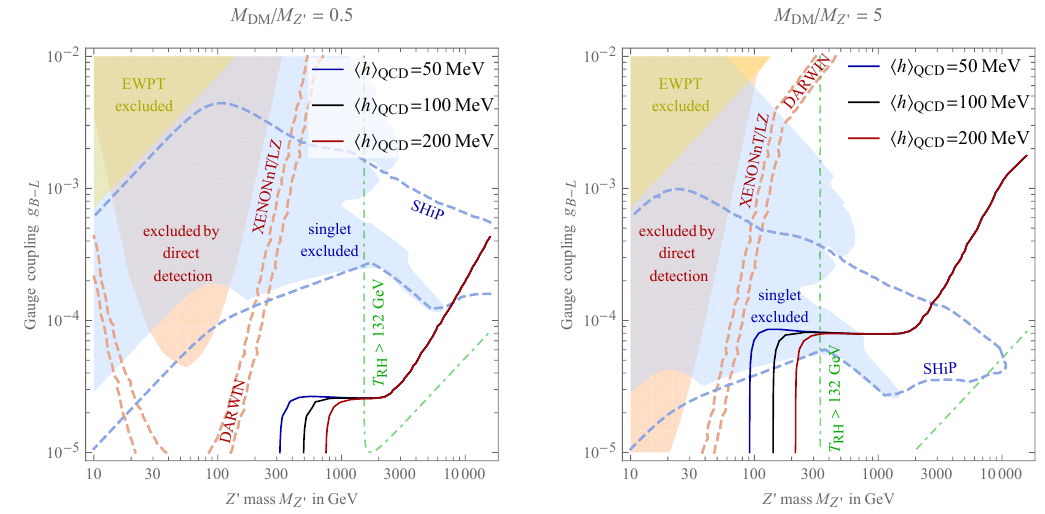
Figure 5 . The observed DM abundance is reproduced along the solid curves, computed for di(cid:11)erent values of the uncertain QCD factor h h i QCD . The region shaded in orange (blue) is excluded by direct DM searches (collider searches for the singlet s ). The region shaded in yellow is excluded by precision data. Dashed curves indicate future detection